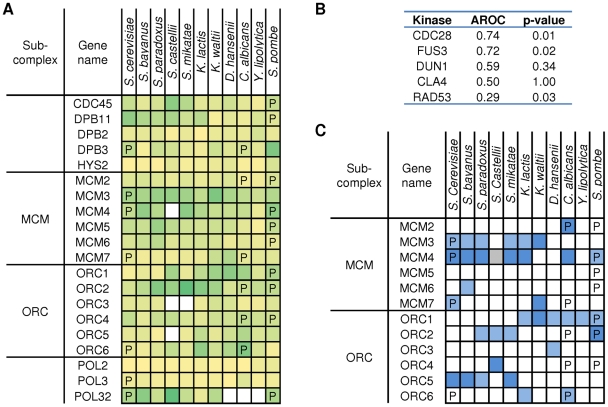
Evolution of phosphoregulation of the pre-replication complex.For S. cerevisiae, C. albicans, and Sc. pombe, proteins found to be phosphorylated experimentally are marked with “P.” (A) For each protein in the species studied, phosphorylation propensity was predicted based on sequence (see Methods) and represented in a color intensity gradient, where darker colors represent increasing predicted phosphorylation likelihood. The AROC value for the prediction of the phosphorylation pattern the three species is 0.67 using the LR method. White squares denote lack of predicted ortholog. (B) The top five kinases predicted to be associated with the ORC and MCM complexes in S. cerevisiae are shown along with the respective AROC value and significance value for prediction of the phosphorylation pattern for the three species (C) Cdc28p phosphorylation propensity was predicted from sequence and classified as poor (white), weak (light blue), or strong (dark blue). Gray denotes lack of predicted ortholog.